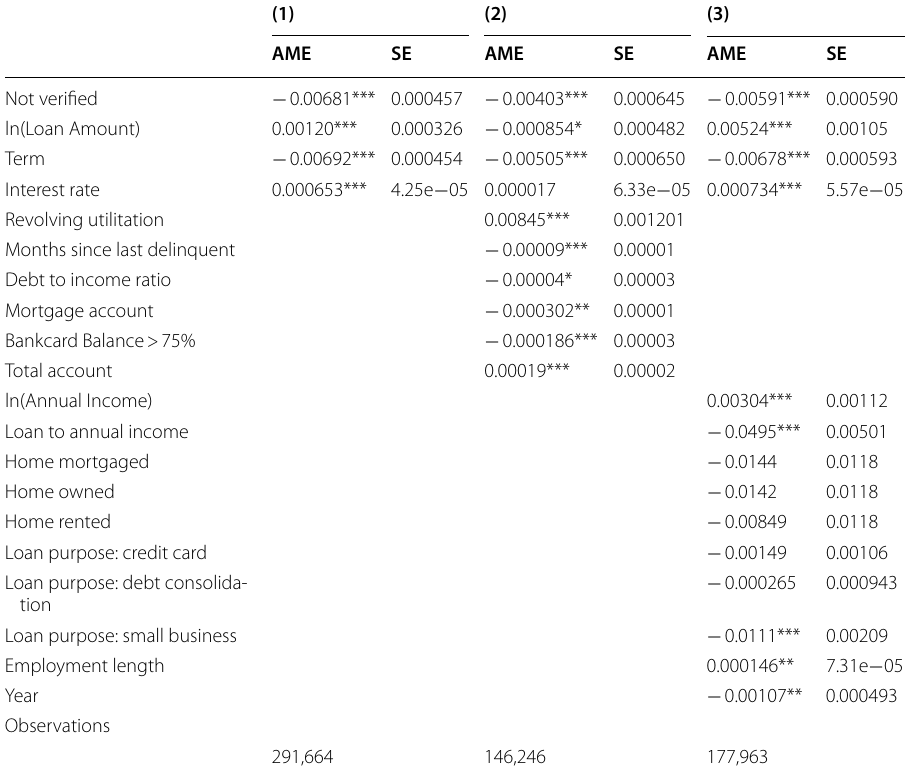
Table 9 Average marginal